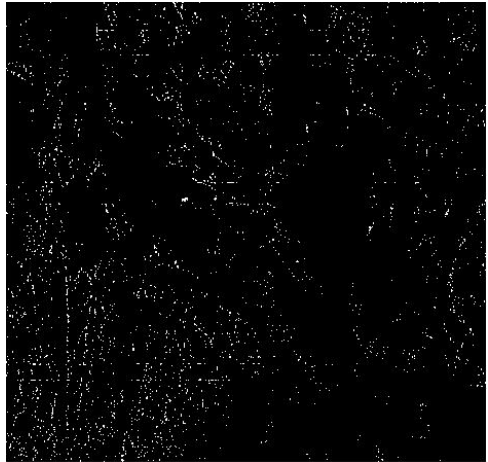
Figure 9. Binary image after intermediate threshold level